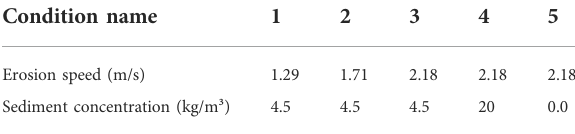
TABLE 1 Accelerated corrosion test conditions for steel